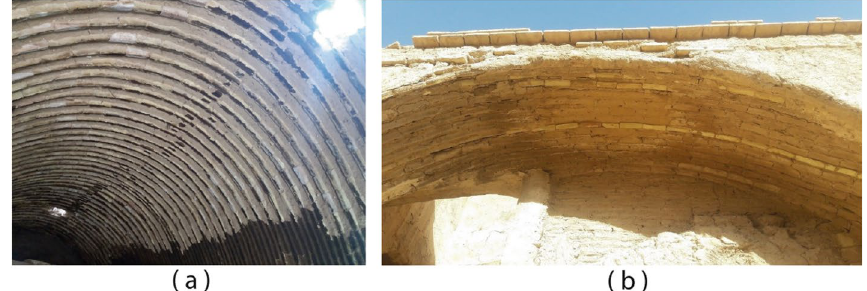
Fig. 18 Application of brick courses in adobe vaults: ( a ) a barrel vault in the Sadrololama house, Yazd (Source: the authors) and ( b ) an arch from Yazd adobe architecture (Source: Ehsan